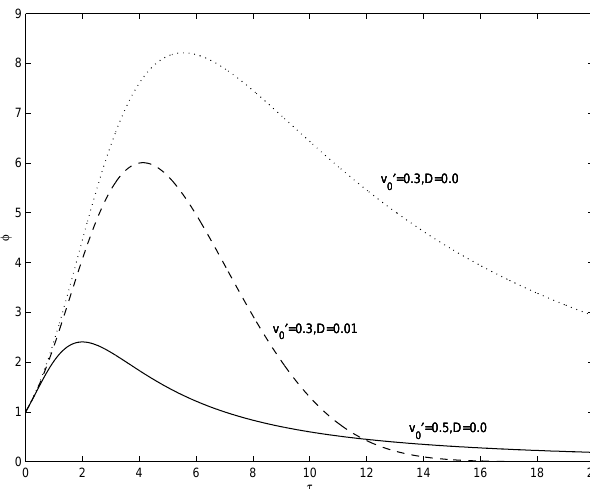
Fig. 1. Solution of Eq. (21) for normalized potential with and with- out dissipation is plotted for different velocity shear parameters for k = 2 . 0. The different curves indicate the reduction of the growth of the RT mode by velocity shear with and without the presence of